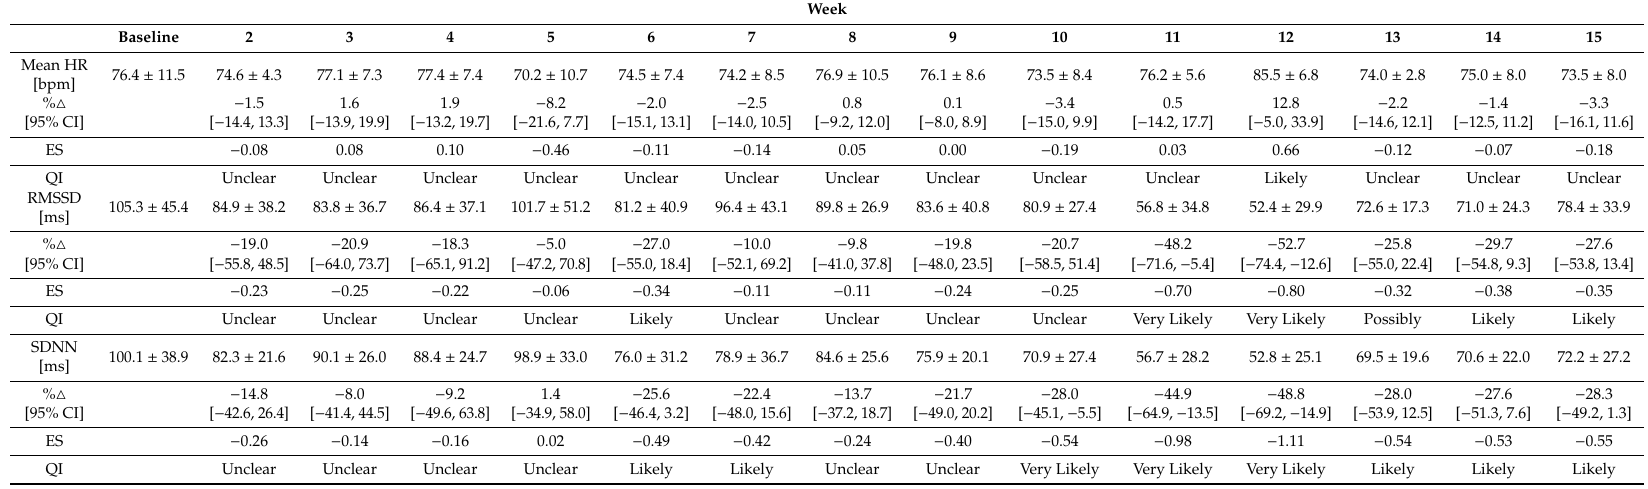
Table 3. Mean values ± standard deviation, variance (95% CI) from baseline, E ff ect Size (ES), and qualitative inferences for heart rate and heart rate variability during the 15-week monitoring